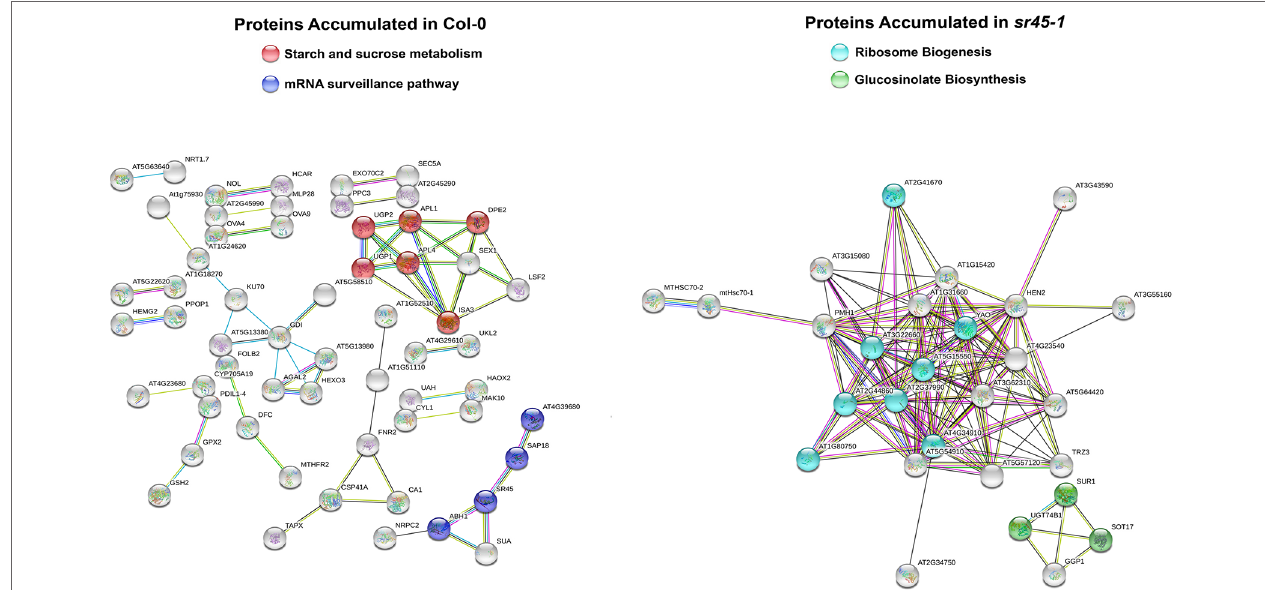
FIGURE 2 | Functional enrichment analyses using STRING version 11.0. Left: Proteins with higher accumulation in Col-0 enriched in two sample pathways as highlighted with two different colors. Right: Proteins with higher accumulation in sr45-1 enriched in two sample pathways as highlighted with two different colors. Each sphere represents a protein node in the network. Each edge presents an existing piece of support evidence collected by STRING. All evidence used to build the protein network was filtered with a high confidence of